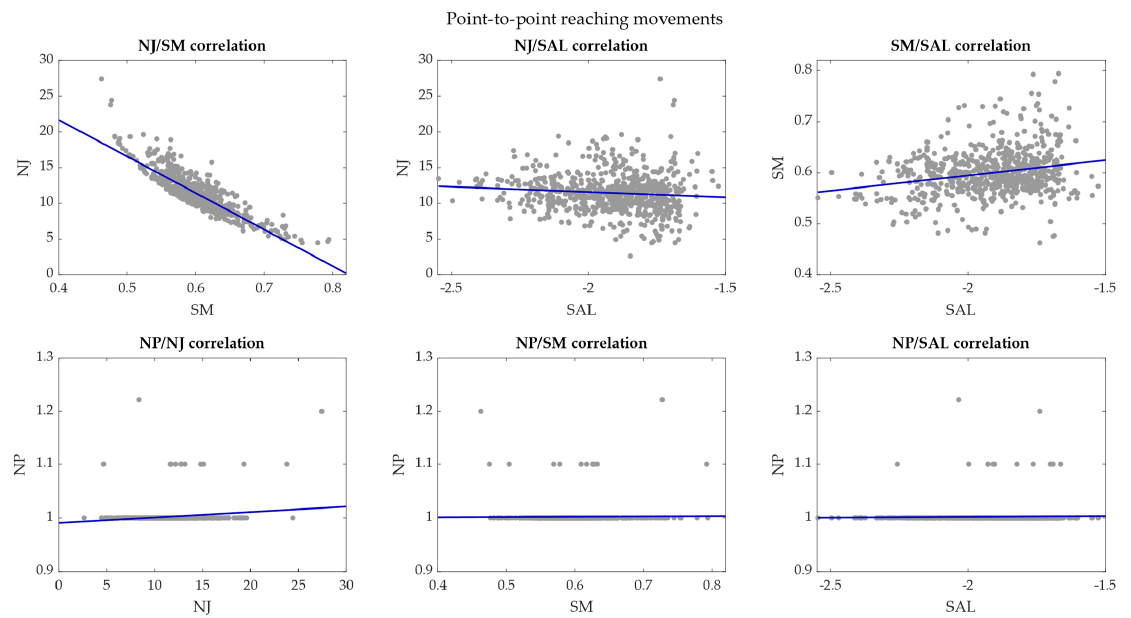
Figure 9. Correlation plots between each possible pair of smoothness metrics—P2P movements. The correlations between pairs of smoothness metrics are reported in each plot and the regression lines are marked in blue.